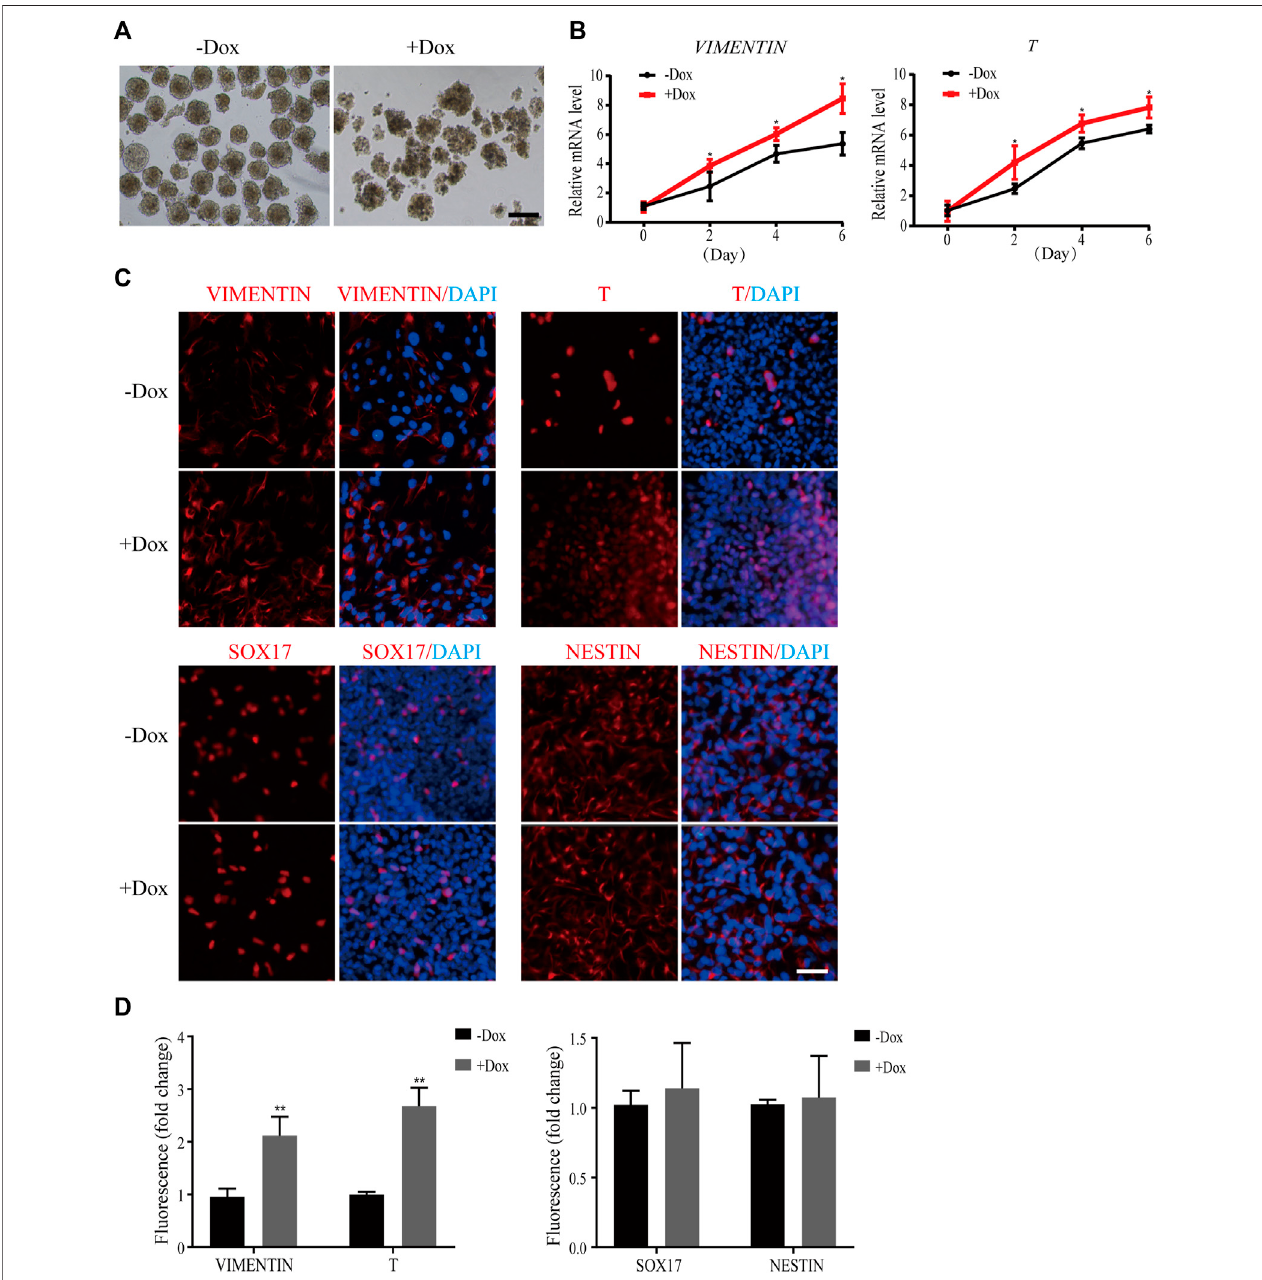
FIGURE 3 | Dox-induced WDR36 knockdown elevated differentiation potential of hEPS1 cells in an EB formation assay. (A) Representative images of WDR36- modi fi ed hEPS1 cells forming EBs in the EB medium. On day 7, EBs were collected and observed under the microscope. Bar = 200 μ m. (B) Expression of mesodermal genes in WDR36-modi fi ed EBs treated with or without Dox. (C,D) Immuno fl uorescent images (C) and quanti fi cation intensity for immuno fl uorescence (D) of WDR36- modi fi ed EBs treated with or without Dox (2 μ g/ml). Bar = 50 μ m; n = 3 experiments; mean ± S. D; two-tailed Student ’ s t -test. *, 0.01 < p < 0.05; **, p < 0.01; no labeling indicates no statistical signi fi